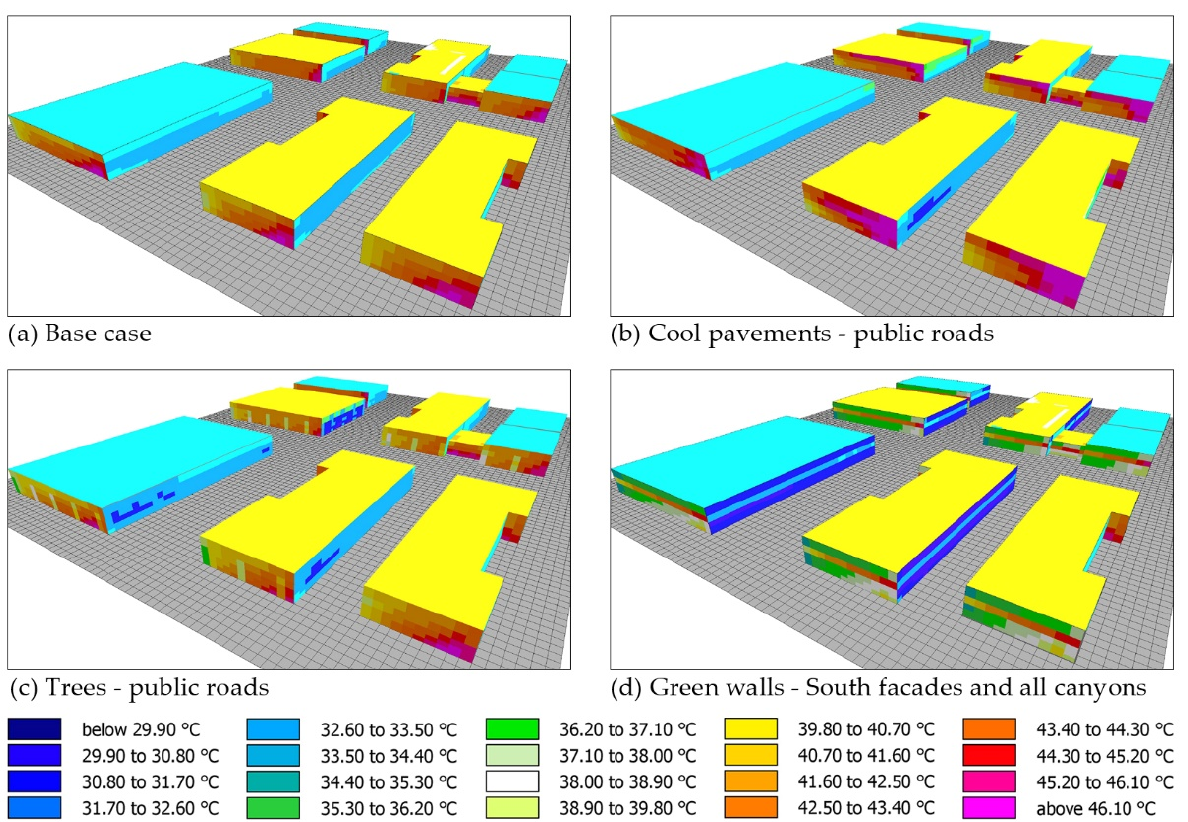
Figure 9. Axonometric view of the industrial district portion, showing the facades’ temperatures in the different configurations: base case ( a ), CP (cool pavements in the public roads) ( b ), TP (trees in the public roads) ( c ) and ( d ) GW.2 (green façades for the southern front and all urban canyons). As highlighted in Figure 9, the most effective solution for a significant reduction in the value of the external surface temperature is the adoption of green walls: the decrease is equal to about 8 ◦ C for the southern oriented facades, while it is equal to 1.78 ◦ C and 3 ◦ C for the eastern and western oriented ones,